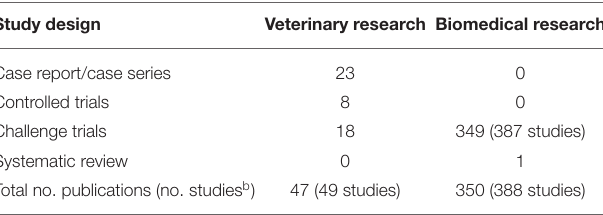
TABLE 1 | Study design a of 397 publications included in a scoping review of the evidence for the medicinal use of honey in animals.